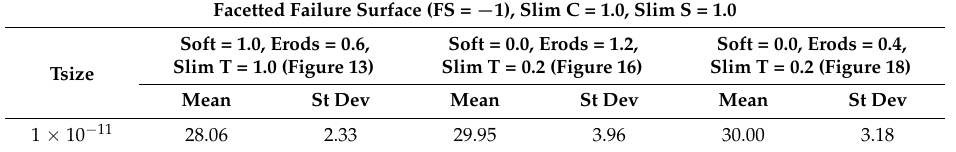
Table 11. Mean and standard deviations (St Dev) for peak deceleration values (0.23 m < wall displacement < 0.29 m) based on five runs of previous high peak models.